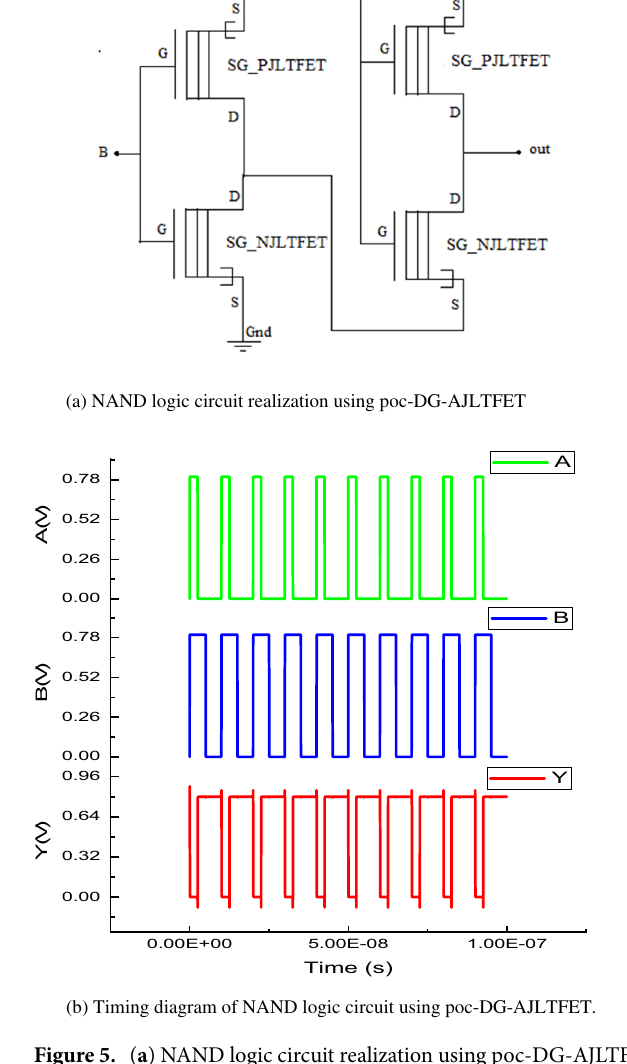
Figure 5. ( a ) NAND logic circuit realization using poc-DG-AJLTFET. ( b ) Timing diagram of NAND logic circuit using